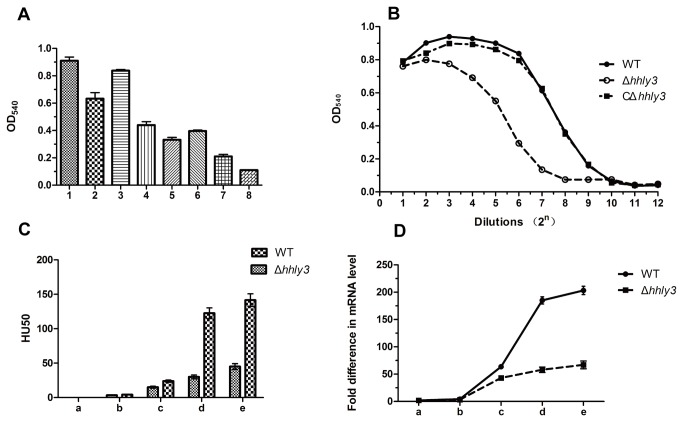
Hemolytic activity analysis.(A) Hemolytic activities of different strains. 1–3, Supernatants of WT, Δhhly3, and CΔhhly3 strains, respectively. 4–8, Pellets of WT, Δhhly3, CΔhhly3, BL21 (pSET2::hhly3), and BL21 (pSET2) strains, respectively.(B) Titration of hemolytic activities of culture supernatants of different strains in the stationary phase.(C) Hemolytic unit analysis of the supernatants of the SS2 strain at different phases of growth.a, early logarithmic phase (OD600 < 0.3). b, mid-logarithmic phase (OD600 = 0.4–0.6). c, late logarithmic phase (OD600 = 0.6–0.8). d, late logarithmic phase (OD600 = 1.0–1.2). e, stationary phase (OD600 > 1.2).(D) Expression profiles of sly at different stages of growth.a, early logarithmic phase (OD600 < 0.3). b, mid-logarithmic phase (OD600 = 0.4–0.6). c, late logarithmic phase (OD600 = 0.6–0.8). d, late logarithmic phase (OD600 = 1.0–1.2). e, stationary phase (OD600 > 1.2).